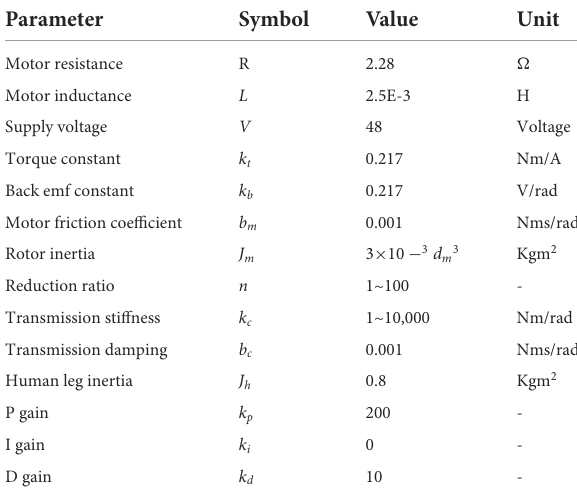
TABLE 4 Specification of high-stiffness tension-amplification